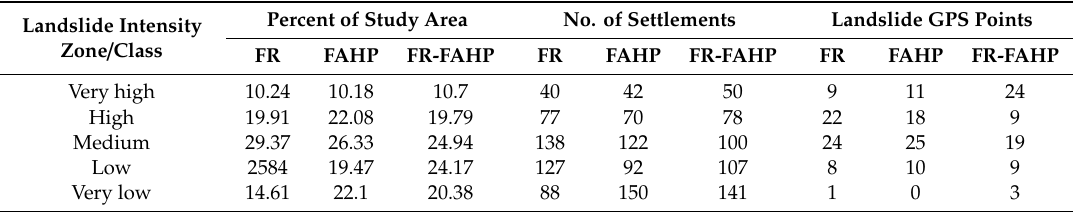
Table 6. Area of each category and the number of observed landslide events.